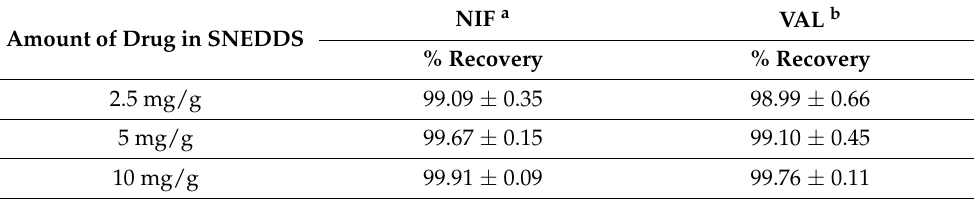
Table 6. Analysis of NIF and VAL in developed in-house SNEDDS formulations. Amount of Drug in